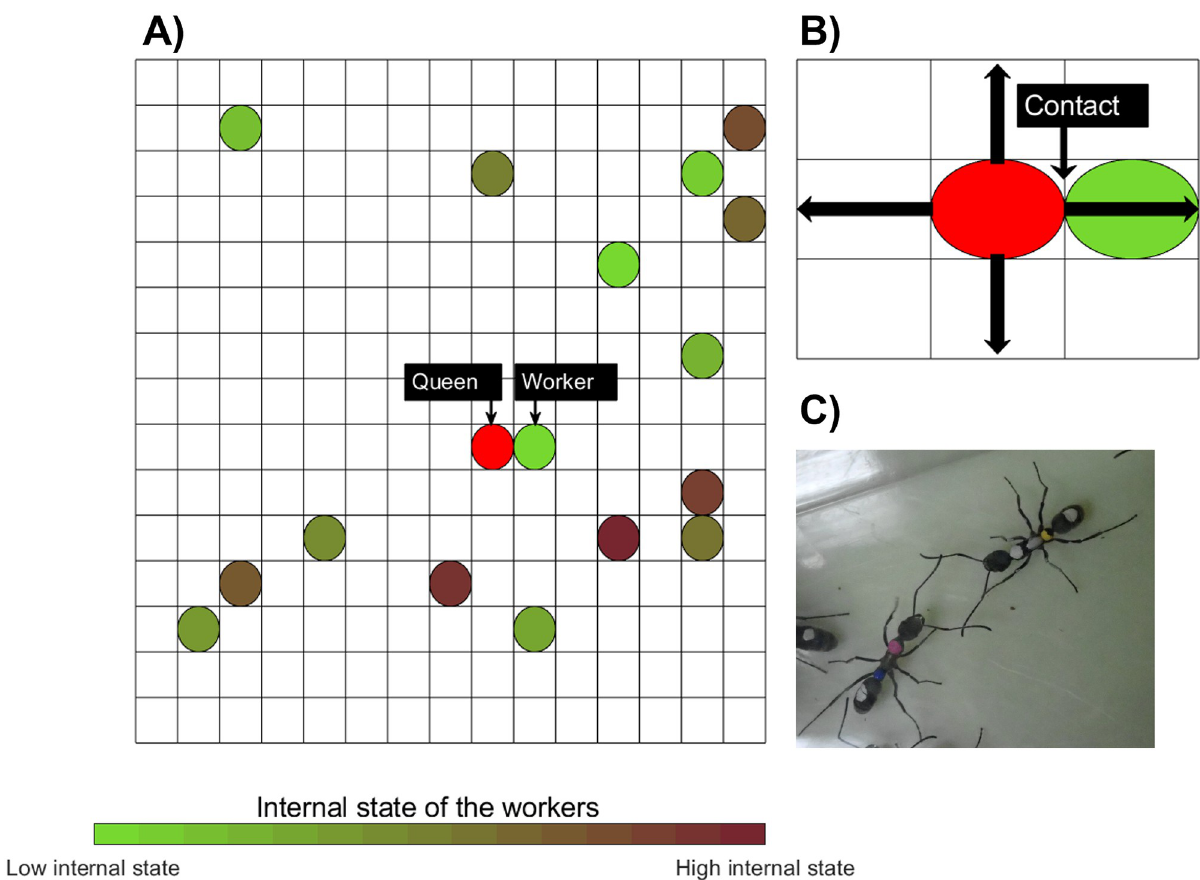
Fig 2. Schematic picture of the simulation environment. A) Grid structure with the queen and workers. B) Contact is established when workers are within range of the queen. In this instance, the threshold was set to 5 units of length. C) Two ants contacting each other by touching antennae.